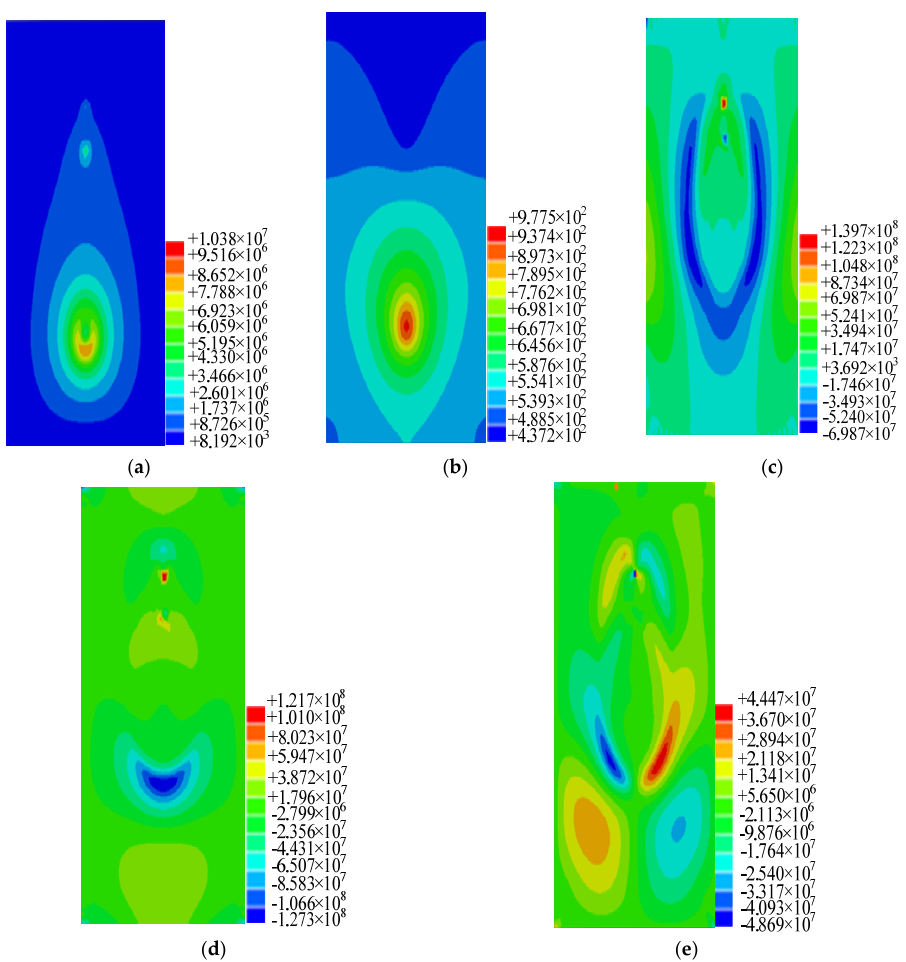
Figure 14. A plate with an inclined isothermal crack at the heating process: ( a ) the distribution of heat flux; ( b ) the distribution of temperature; ( c ) the distribution of stress σ x ; ( d ) the distribution of stress σ y ; ( e ) the distribution of stress σ xy . Appl. Sci. 2017 , 7 , 69